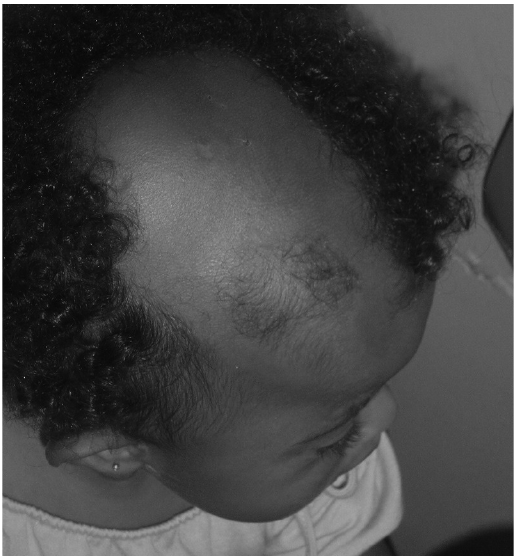
Figure 1 - The hairless lesion (“naevus psiloliparus”)